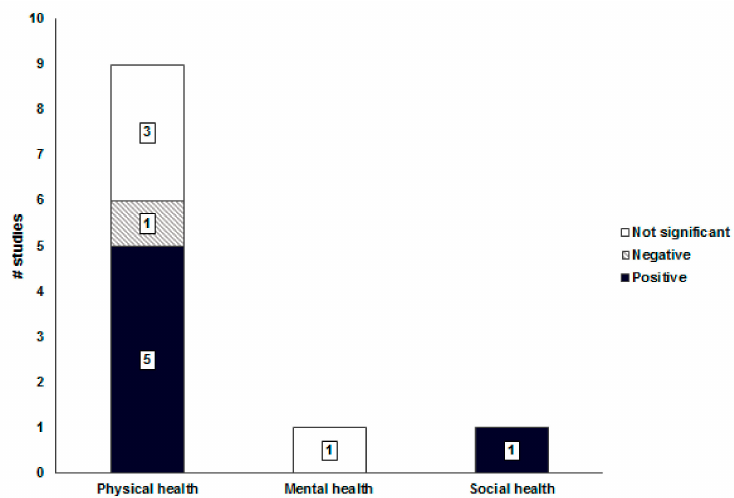
Figure 2. Associations between mixed land use and health-related